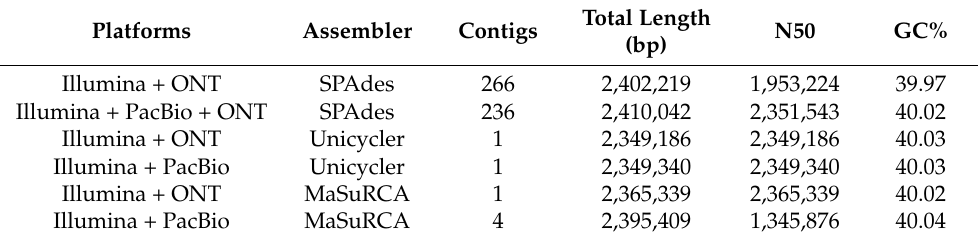
Figure 2. Comparison of results of independent assembly strategies. ( A ) Genome assembled with nanopore reads; ( B ) longest contig assembled with PacBio reads; ( C ) genome assembled with Illumina reads. Plots were obtained by using Bandage on the “assembly_graph.gfa” output file from SPAdes or the “contig.gfa” output file from Canu. Connections between contigs represent overlaps between contig ends. Table 2. Statistics of genome-assembly results of hybrid assembly strategies.